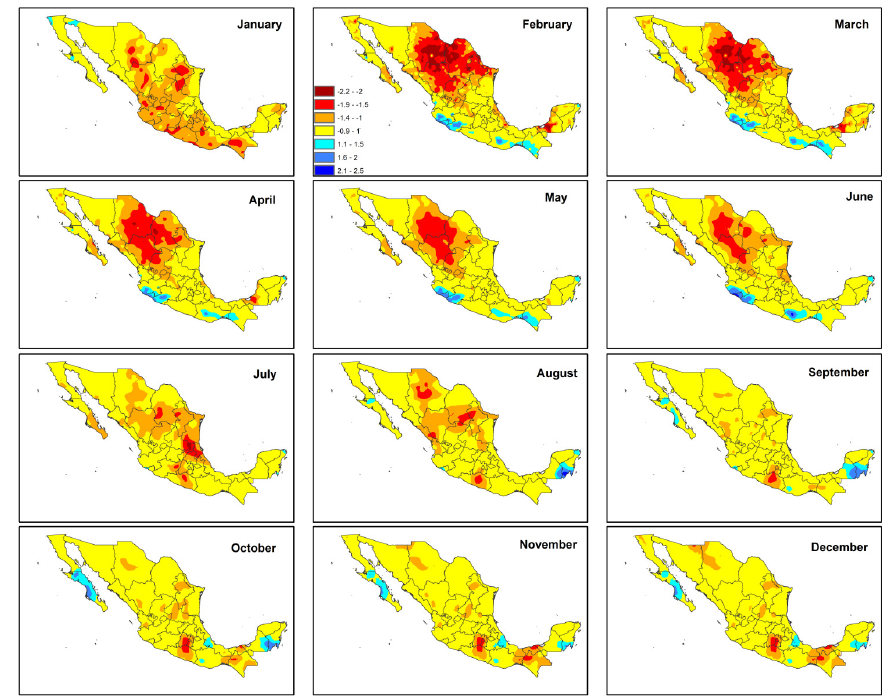
Figure 15. Drought monitoring based on TRMM 3B42 twelve-month Standardized Precipitation Index for 2012.